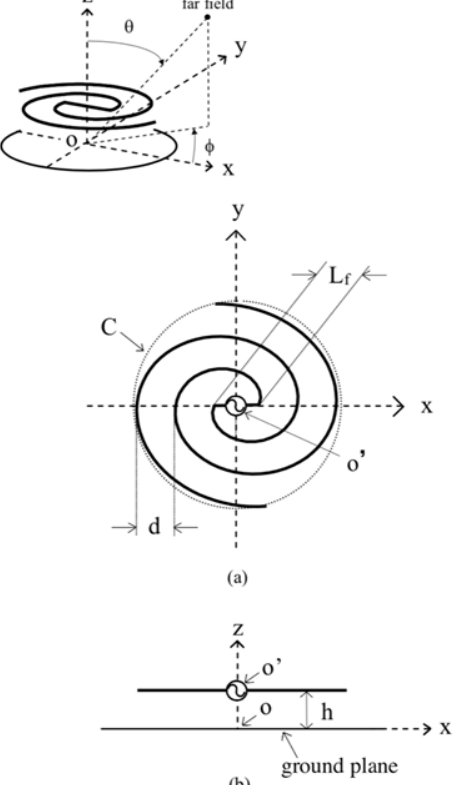
Figure 1. Two-arm spiral antenna: ( a ) perspective and top views; ( b ) side